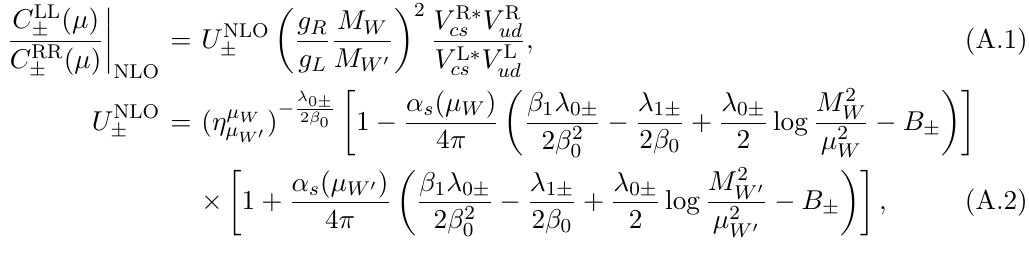
Figure 2 . Maximal di(cid:11)erence in the CP asymmetry in D + SU(2) R (cid:2) U(1) B (cid:0) L model (without charge symmetry). The bands represent the combination of theoretical uncertainty evaluated by varying the matching scales as M W = 2 (cid:20) (cid:22) W (cid:20) 2 M W and M W 0 = 2 (cid:20) (cid:22) W 0 (cid:20) 2 M W 0 , and uncertainty from the 1 (cid:27) errors of the diagrammatic